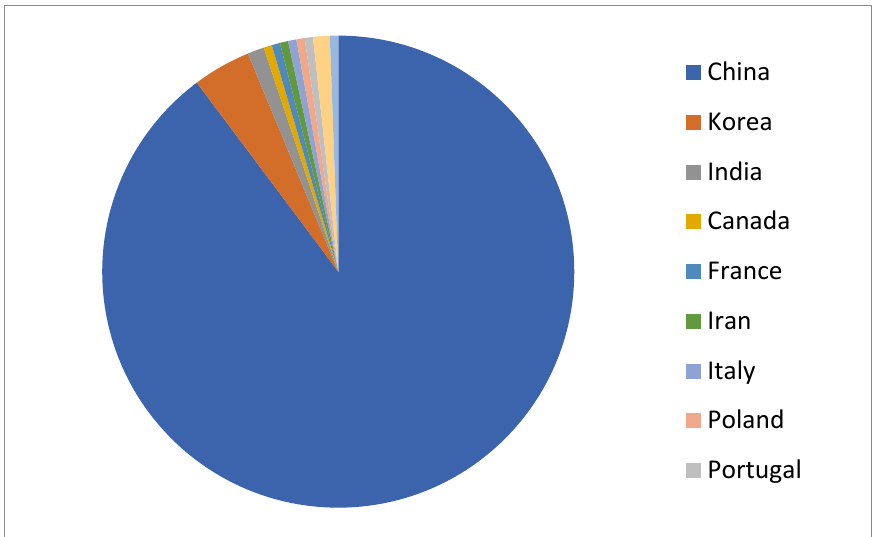
Figure 4. The percentages of the author countries.